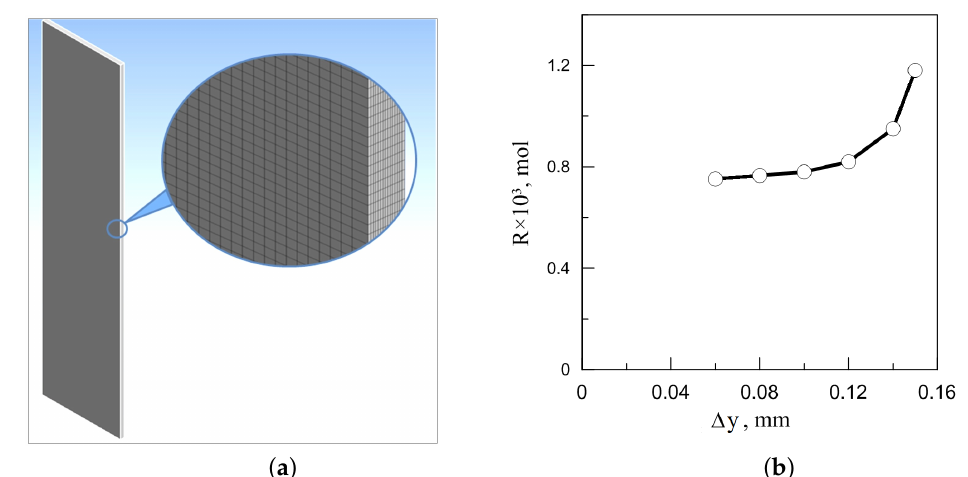
Figure 9. ( a ) The ANSYS meshing in 3D numerical simulations of the chemoconvective flow in a slab reactor, the computational grid with 300 × 15 × 1250 cells is shown; ( b ) the convergence test of the total reaction product R ( t ) released during the first 500 s of flow evolution in a vertically oriented reactor with gradual grid refinement. ∆ y stands for the cell size in the y direction. When refining the grid, the cell element (hexahedron) decreases